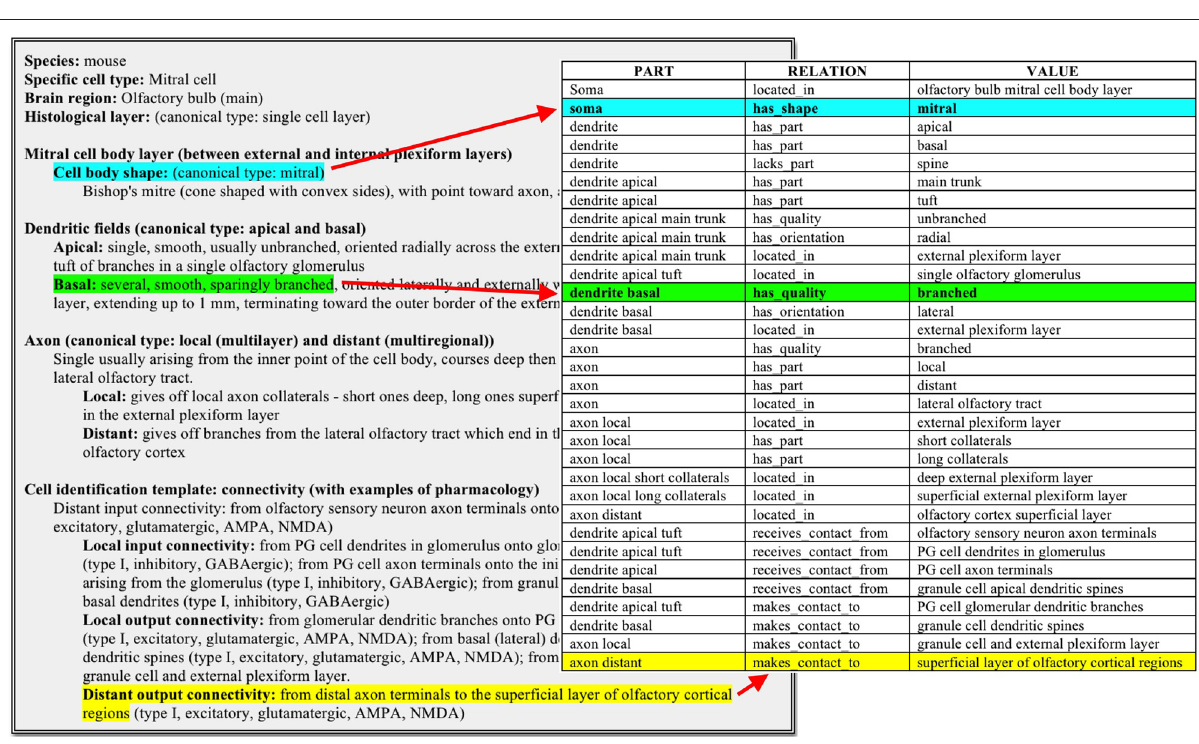
Curator Interface (http://incfnrci.appspot.com) facilitates